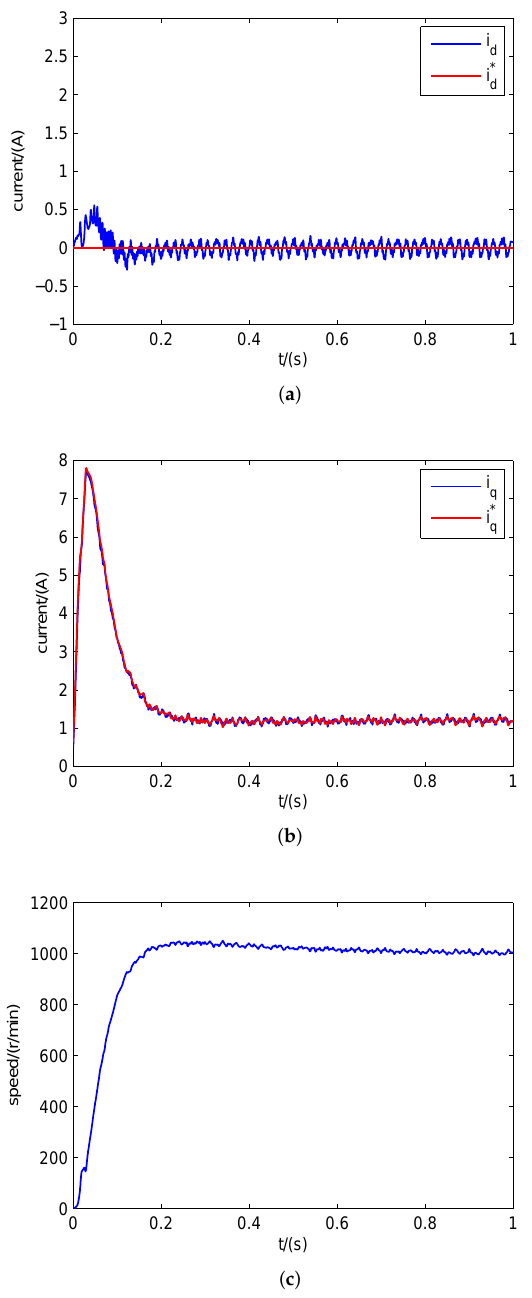
Figure 11. Experimental results with the proposed method: ( a ) d-axes current; ( b ) q-axes current; and ( c ) speed